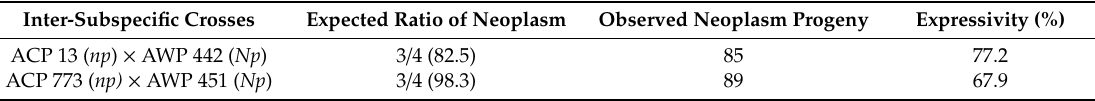
Table 3. Expressivity of neoplasm in F 2 populations derived from inter-subspecific crosses between P. sativum subsp. sativum and P. sativum subsp. elatius. Inter-Subspecific Crosses Expected Ratio of Neoplasm Observed Neoplasm Progeny